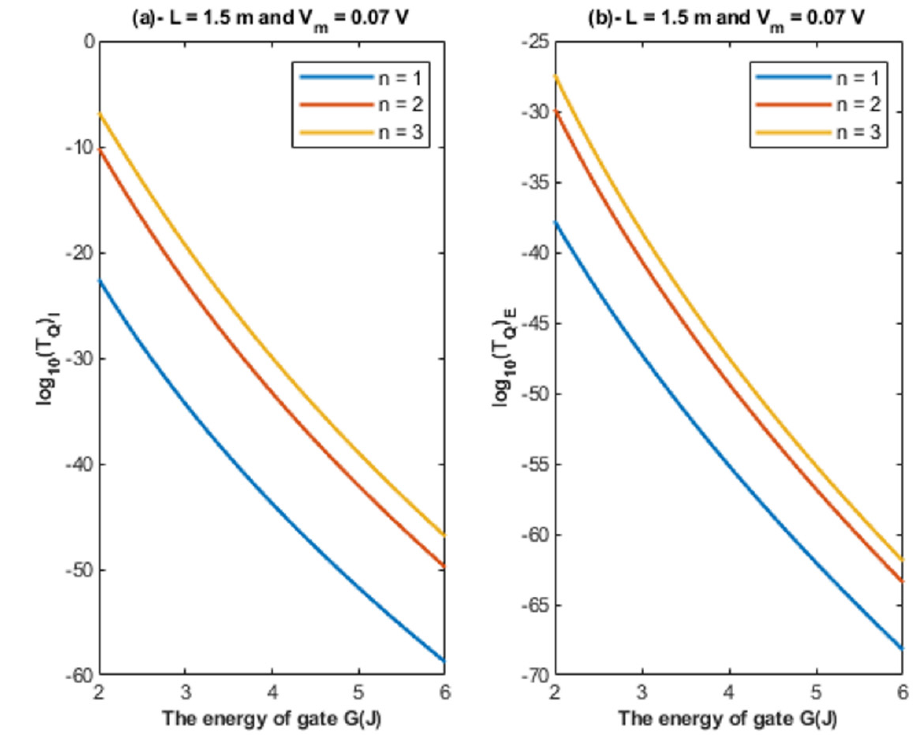
Figure 6. ( a , b ): The figure represents the relationship between the energy of gate G and the common logarithm of the tunneling probability of the intracellular chloride ions tunneling probability of the extracellular chloride ions are investigated at different values of gate location and according to the setting values indicated above each graph.